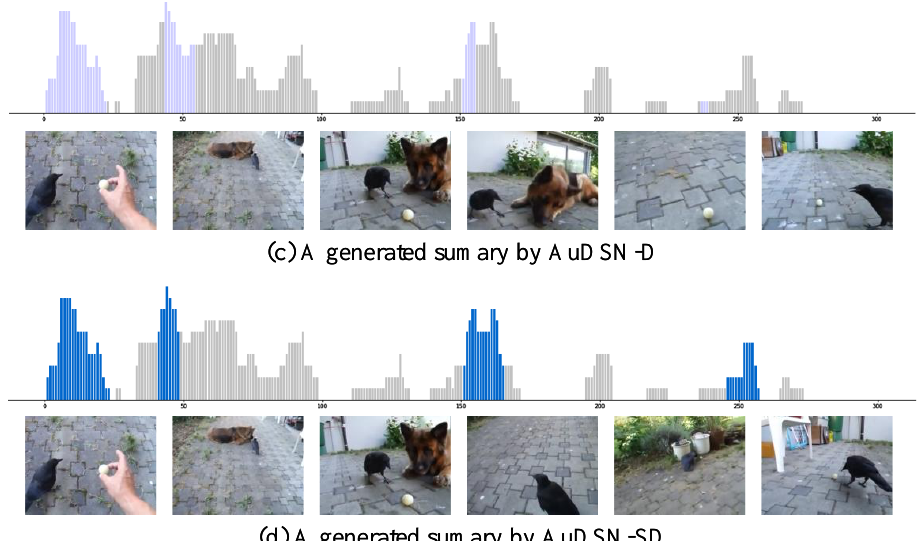
Figure 7. Video summaries generated by all variants of the proposed method.